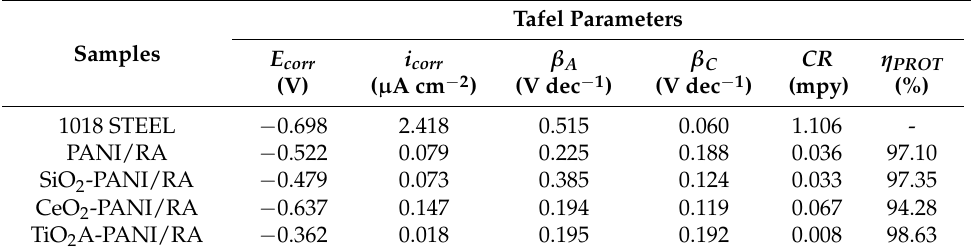
Table 1. Tafel parameters obtained for uncoated steel and PANI-base coatings immersed in 3.5% NaCl solution.